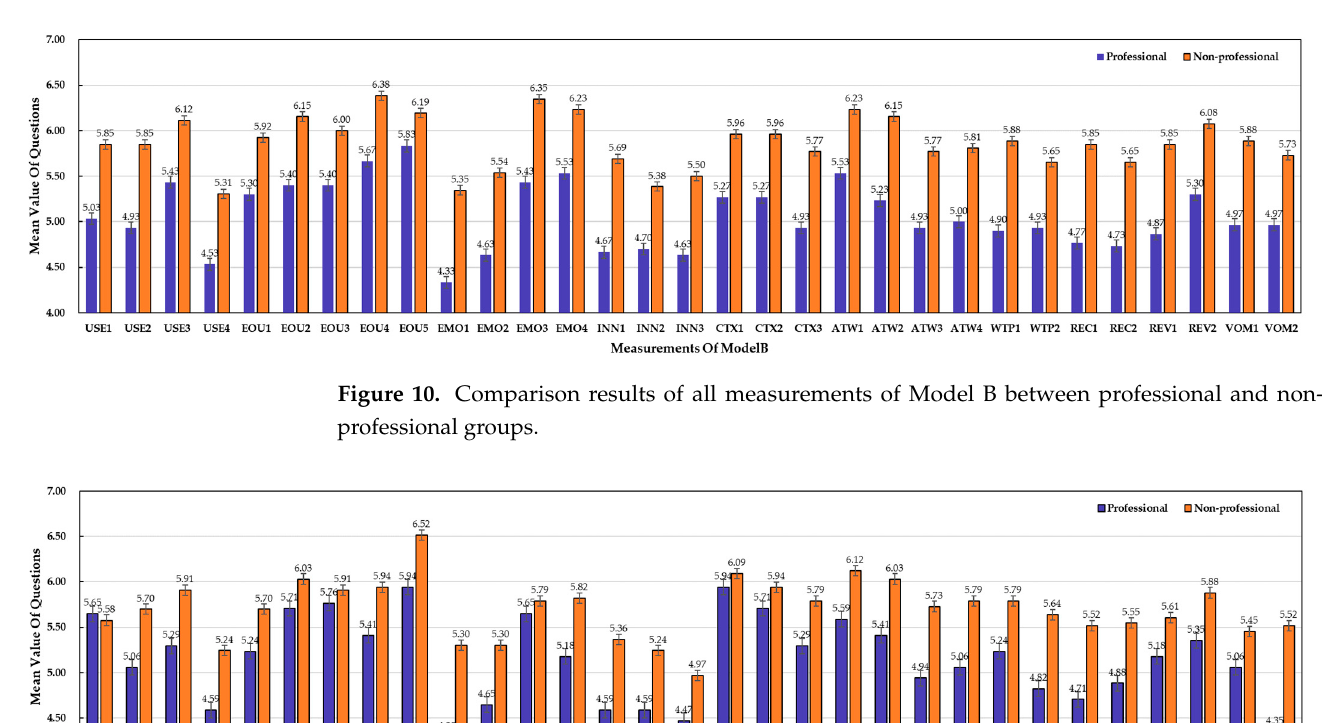
Figure 9. Comparison results of all measurements of Model A between professional and non-pro- fessional groups.